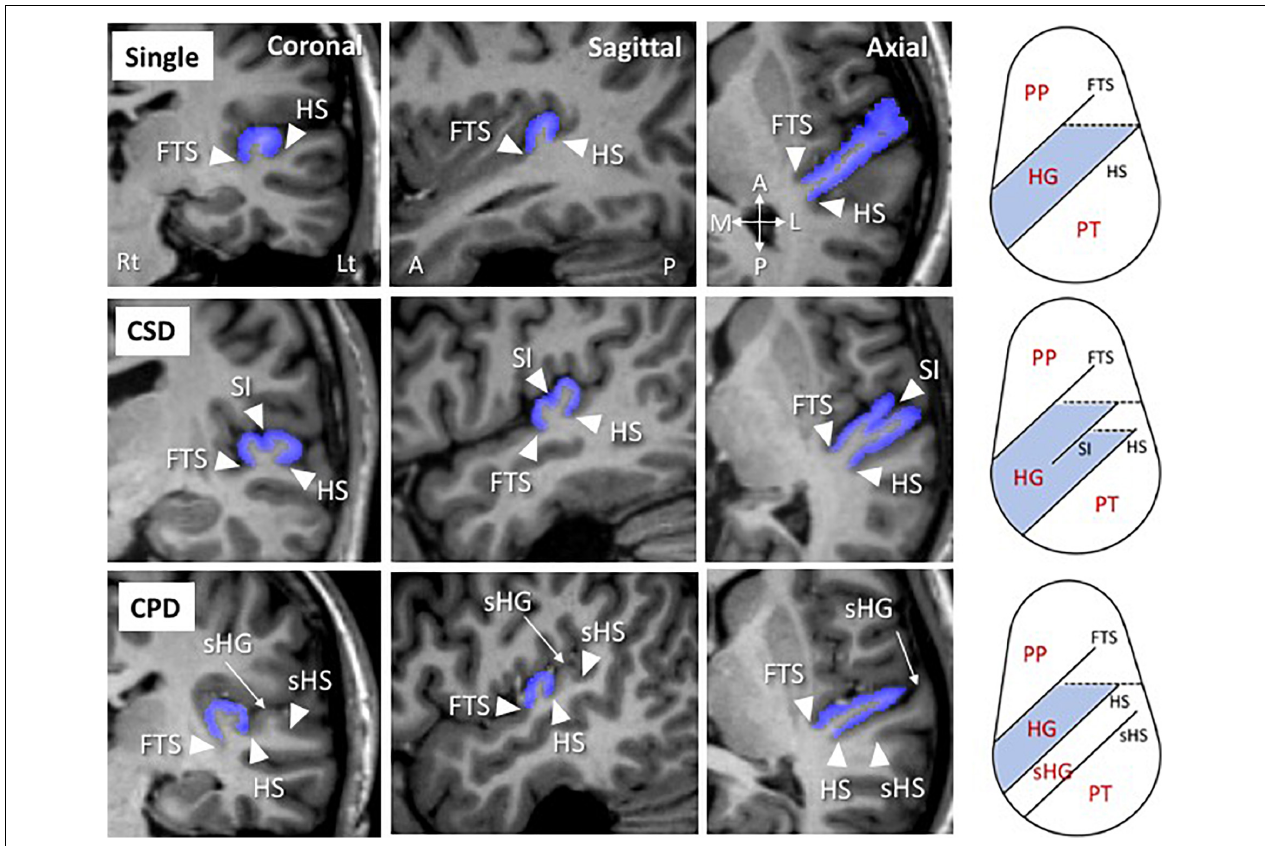
FIGURE 1 | Sample MR images of Heschl’s gyrus (HG; colored in blue) in participants with different gyrification patterns. Schematic drawings of the superior temporal surface on an axial view are also shown (right). A, anterior; CPD, complete posterior duplication; CSD, common stem duplication; FTS, first